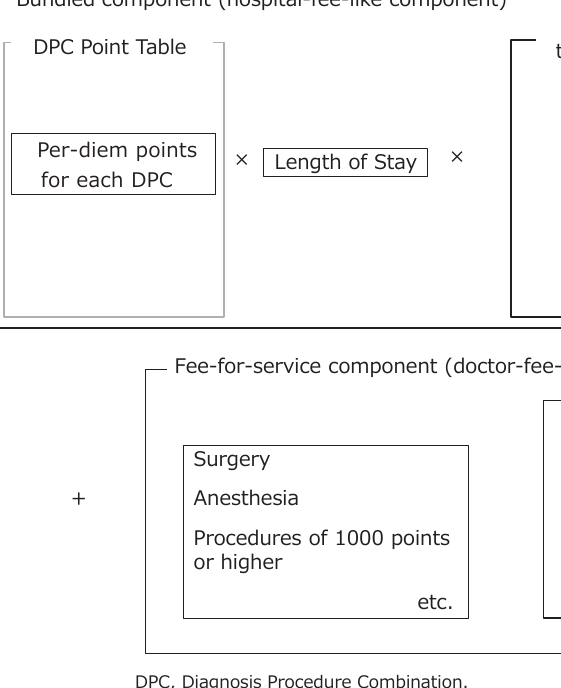
Figure 2. Composition of DPC-based medical service fee payment (bundled component and fee-for-service component)